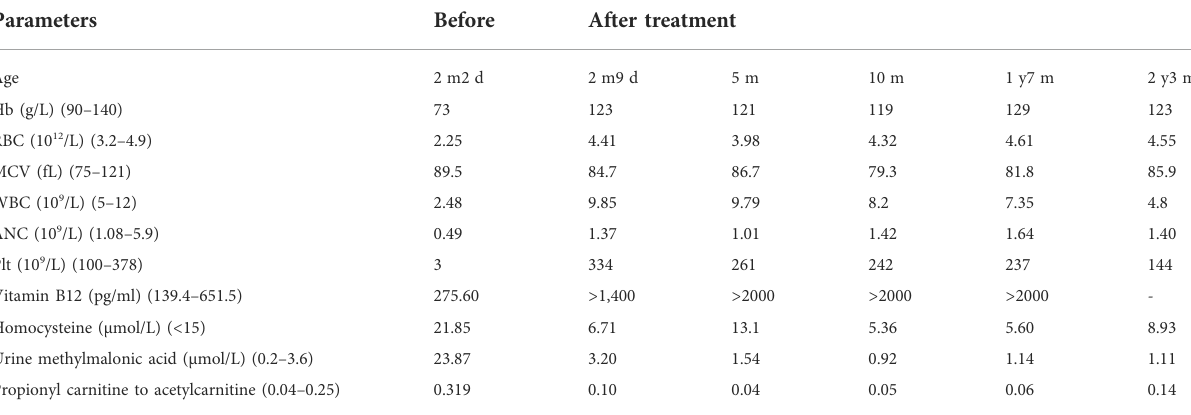
TABLE 2 Laboratory fi ndings of patients before and after hydroxy-Cbl treatment.